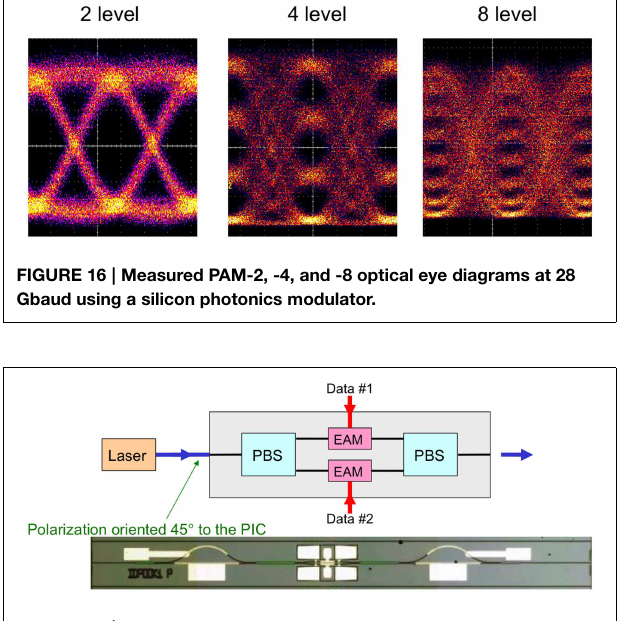
FIGURE 18 | DP-DQPSK receiver in silicon photonics. Uses optical polarization tracking. The upper figure shows a schematic, and the lower figure a device photograph. The incoming signal is separated into two